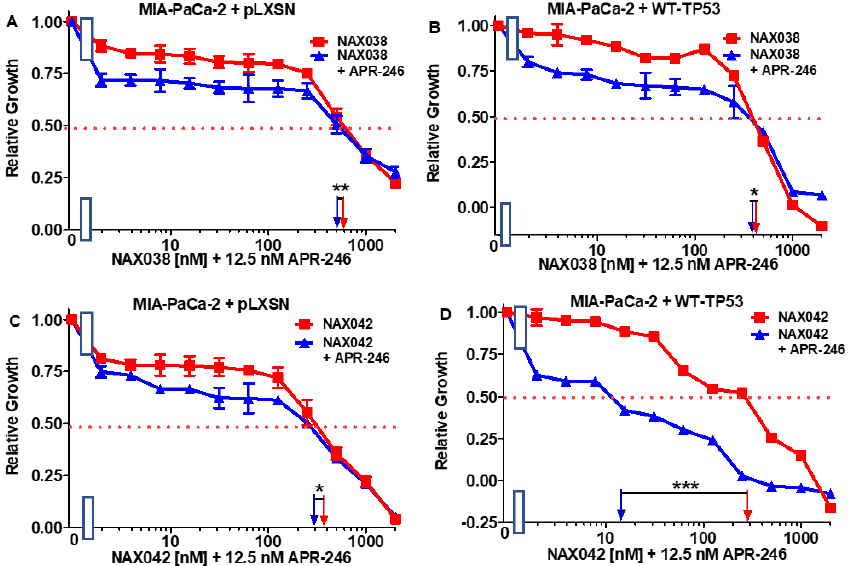
Figure 5. APR-246 has minimal effects on the responses of NAX038 on MIA-PaCa-2 cells in the presence and absence of WT-TP53, while APR-246 enhances the responses of NAX042 in MIA-PaCa-2 cells when WT-TP53 is present. Panel ( A ) MIA-PaCa-2 + pLXSN cells treated with different concentrations of NAX038 (red squares) or with different concentrations of NAX054 and a low dose of APR-246 (blue triangles). Panel ( B ) MIA-PaCa-2 + WT-TP53 cells treated with different concentrations of NAX038 (red squares) or with different concentrations of NAX038 and a low dose of APR-246 (blue triangles). Panel ( C ) MIA-PaCa-2 + pLXSN cells treated with different concentration of NAX042 (red squares) or with different concentrations of NAX042 and a low dose of APR-246 (blue triangles). Panel ( D ) MIA-PaCa-2 + WT-TP53 cells treated with different concentrations of NAX042 (red squares) or with different concentrations of NAX042 and a low dose of APR-246 (blue triangles). The measurements were repeated 4 times, and similar results were observed. *** = p < 0.0001, ** = p < 0.005, * = p < 0.05. A dose of APR-246 had a similar mild effect on the sensitivity of MIA-PaCa-2 + pLXSN to NAX042 (Figure 5, Panel C). In contrast, APR-246 had a more significant effect on the sensitivity of MIA-PaCa-2 + WT-TP53 cells to NAX042 as the IC 50 decreased 23- fold, from 300 to 13 nM (Figure 5D). APR-246 decreased the sensitivity of MIA-PaCa-2 + pLXSN cells to NAX053 only 1.5- fold (Figure 6, Panel A), but it had a more significant on the sensitivity of MIA-PaCa-2 + WT-TP53 cells to NAX053 as the IC 50 decreased 100-fold from 200 to 2 nM (Figure 6B).